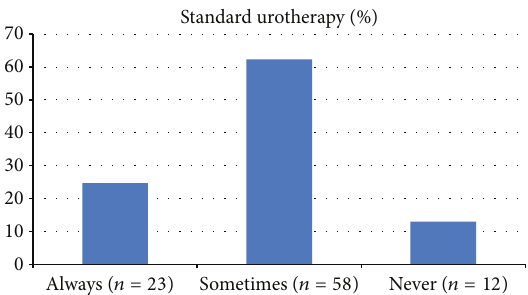
Figure 3: Application rates of the standard